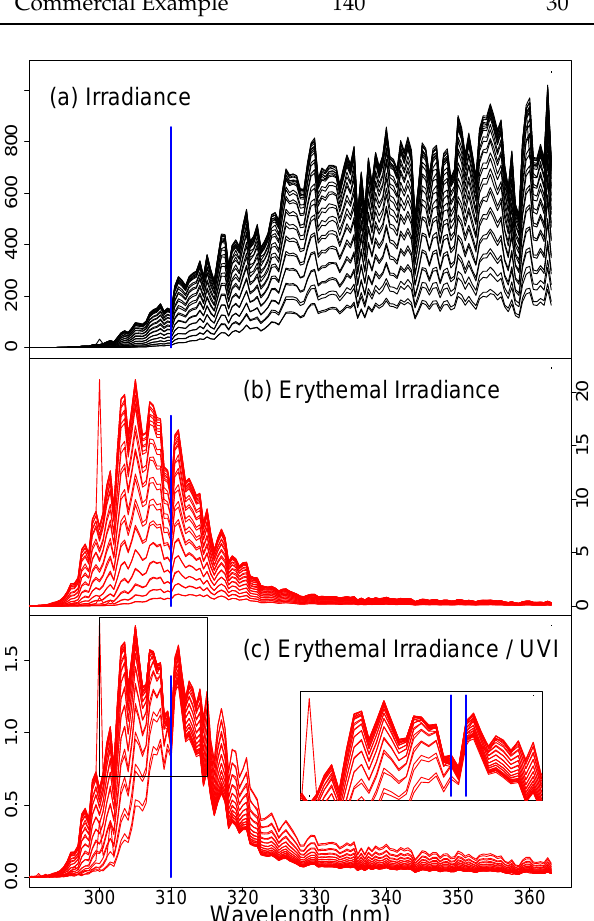
Figure 3. Graphical derivation of the result. ( a ) All UV spectra (mW/m 2 /nm) from Acadia National Park in Maine, US, on 21 June 2000, with UVI > 0.5. ( b ) The same spectra weighted by the erythema action spectrum (Figure 1d). ( c ) These spectra are normalized by UVI (mW/m 2 /nm/UVI). After normalization, the spectra collapse, nearly to a point, at 310 nm. The available code may be used by the reader to reproduce this figure for any location and date for which UV Net data were